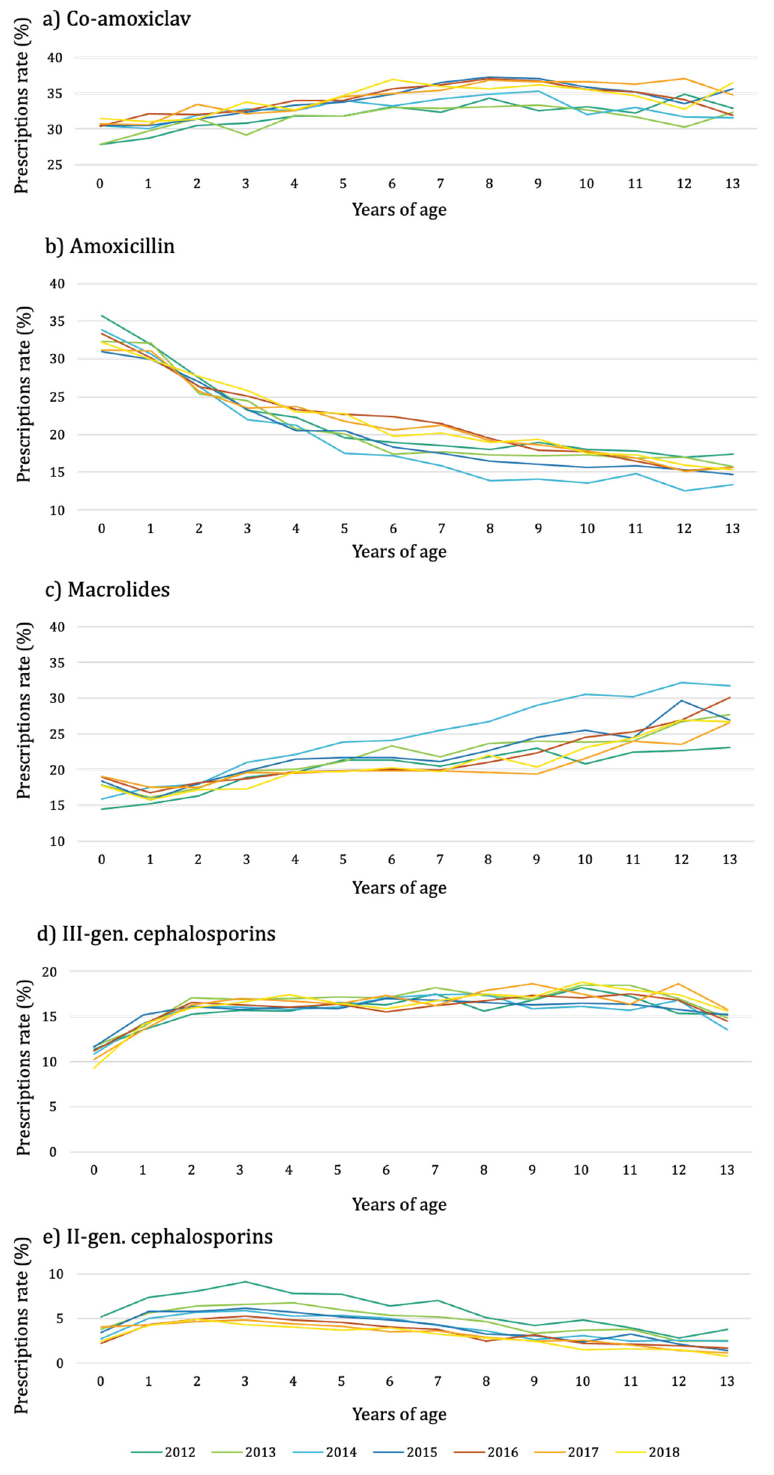
Figure 3. Antibiotic prescription rate stratified by years of age, antibiotic class (co-amoxiclav, Panel ( a ); amoxicillin, Panel ( b ); macrolides, Panel ( c ); third-generation cephalosporins, Panel ( d ); second- generation cephalosporins, Panel ( e )), and calendar year, 2012–2018. Only antibiotic classes with